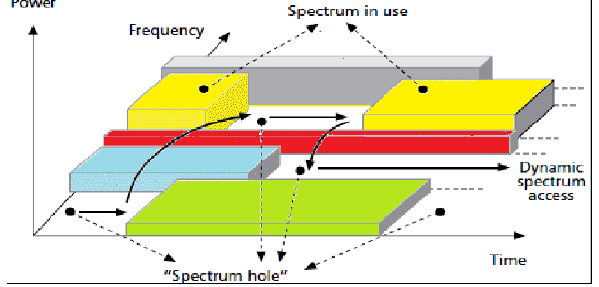
Fig 1 Illustration spectrum sensing